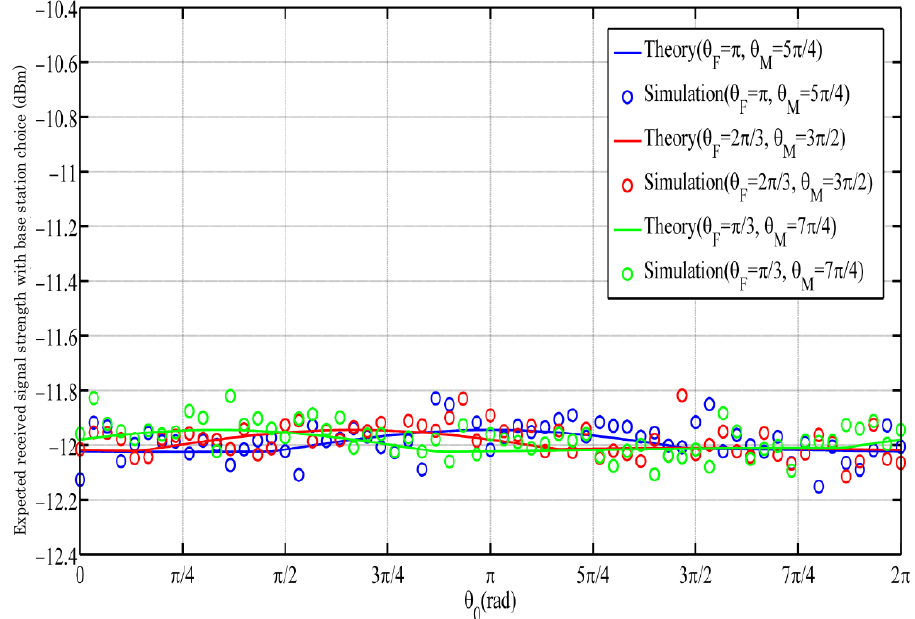
Figure 9. When r = 2 m/s, expected received signal strength (RSS) with base station